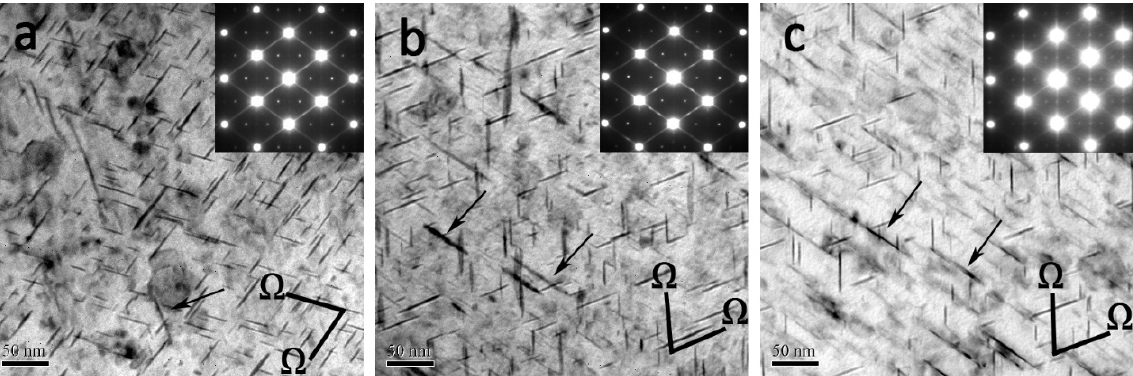
Figure 7. EDS mapping of selected region in Figure 6b.